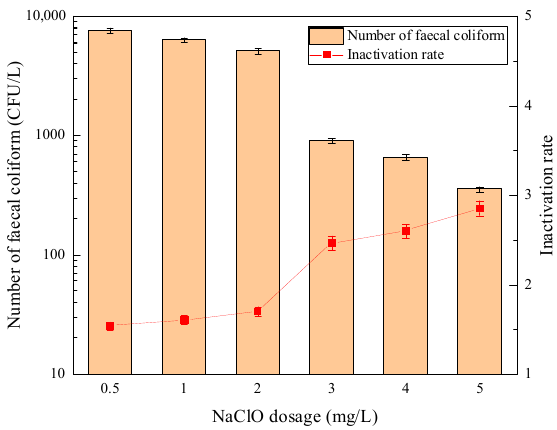
Figure 3. The sterilization effect of “Method B”.